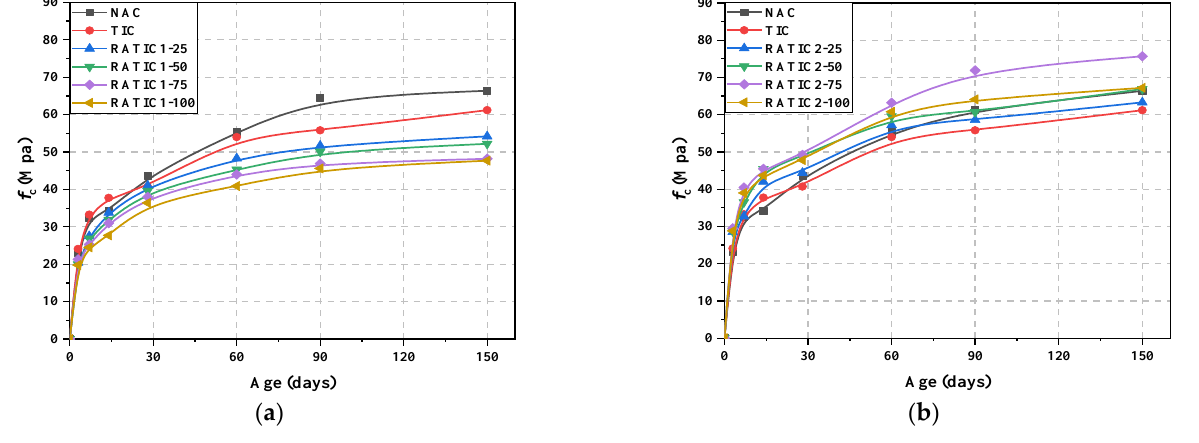
Figure 7. The compressive strength of RATIC at different ages: ( a ) RATIC1; ( b ) RATIC2.